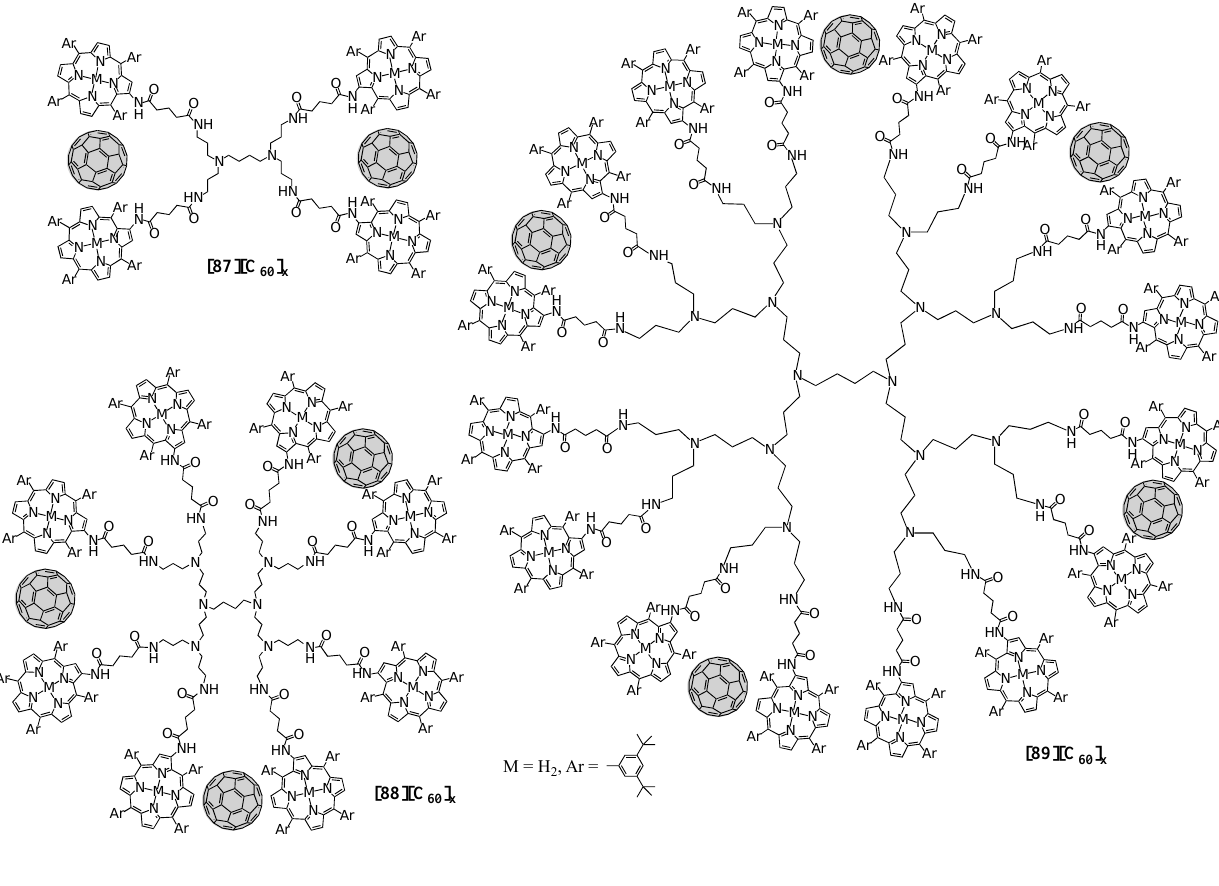
Figure 16. Noncovalent ensembles of C dendrimers 87 - 89 decorated at the surface by multiple porphyrin